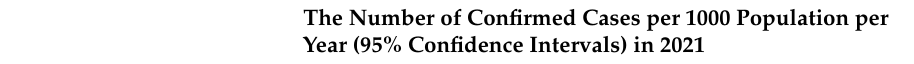
Table 2. The association of the vaccination rate with the number of confirmed COVID-19 cases per year for the United States and